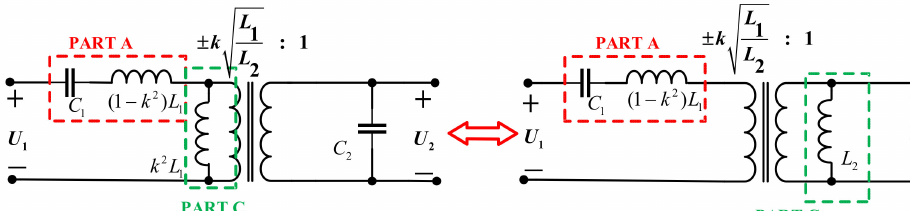
Figure 7. The equivalent model of the II_CV_CV circuit.